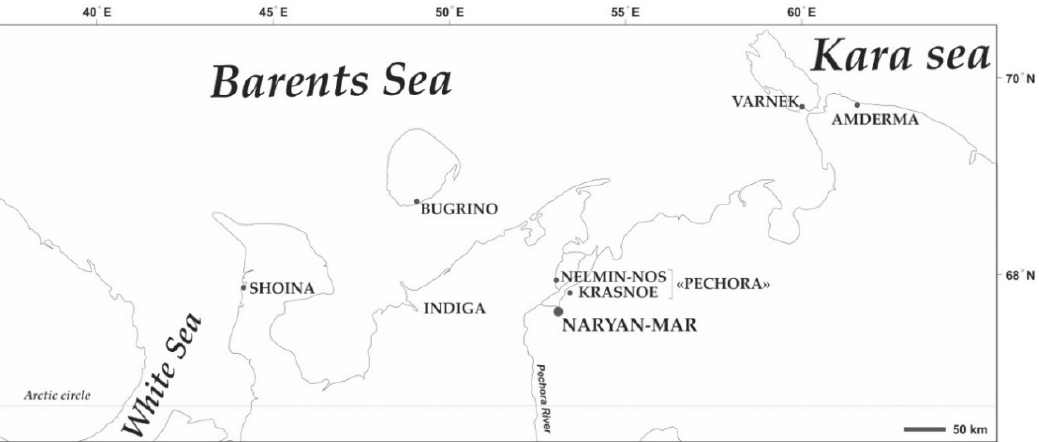
Figure 1. Location of the study settlements. The map was created by Andrey S. Aksenov using CorelDRAW Graphics Suite X4 software (license certificate № 30064931). (https://www.coreldraw.com/); the topographic base of the map was created with Natural Earth Free Vector and Raster Map Data (https://www.naturalearthdata.com).